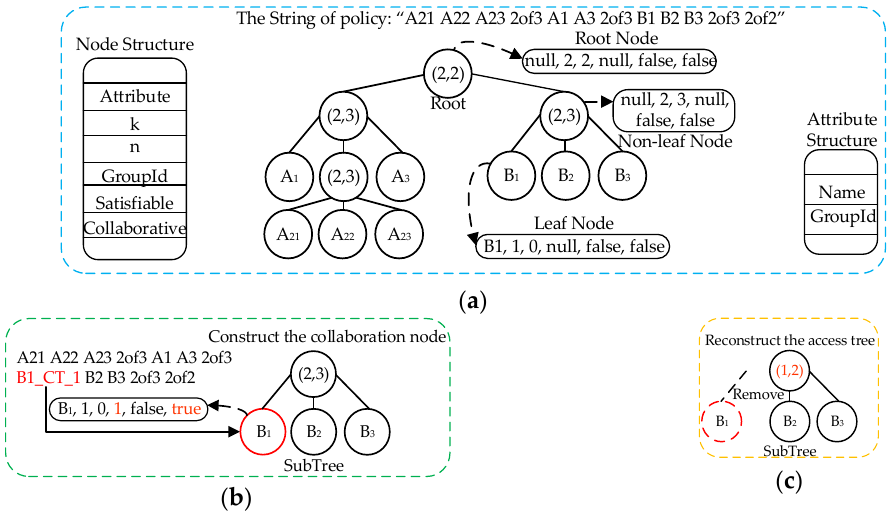
Figure 4. Data structure of the construction of the access tree: ( a ) the data structure for all kinds of nodes and attributes; ( b ) the construction of the collaboration node; ( c ) the reconstruction mechanism of the access policy.